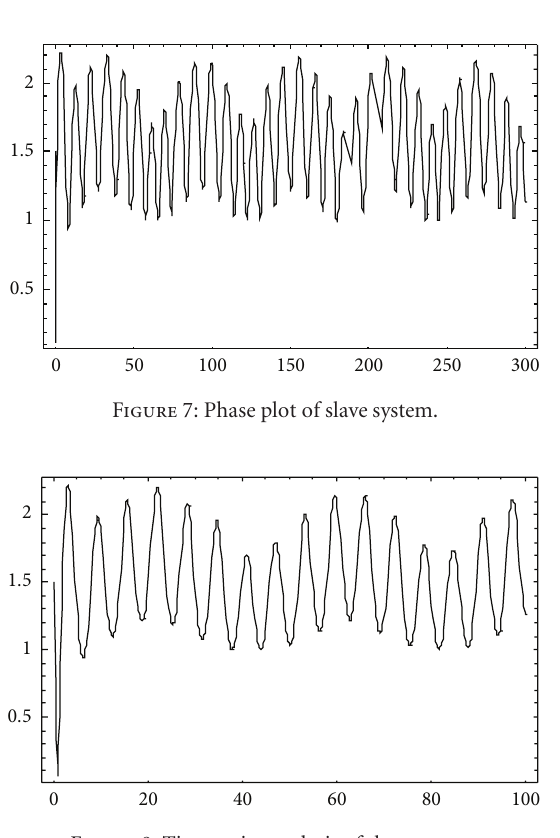
Figure 8: Time series analysis of slave system.